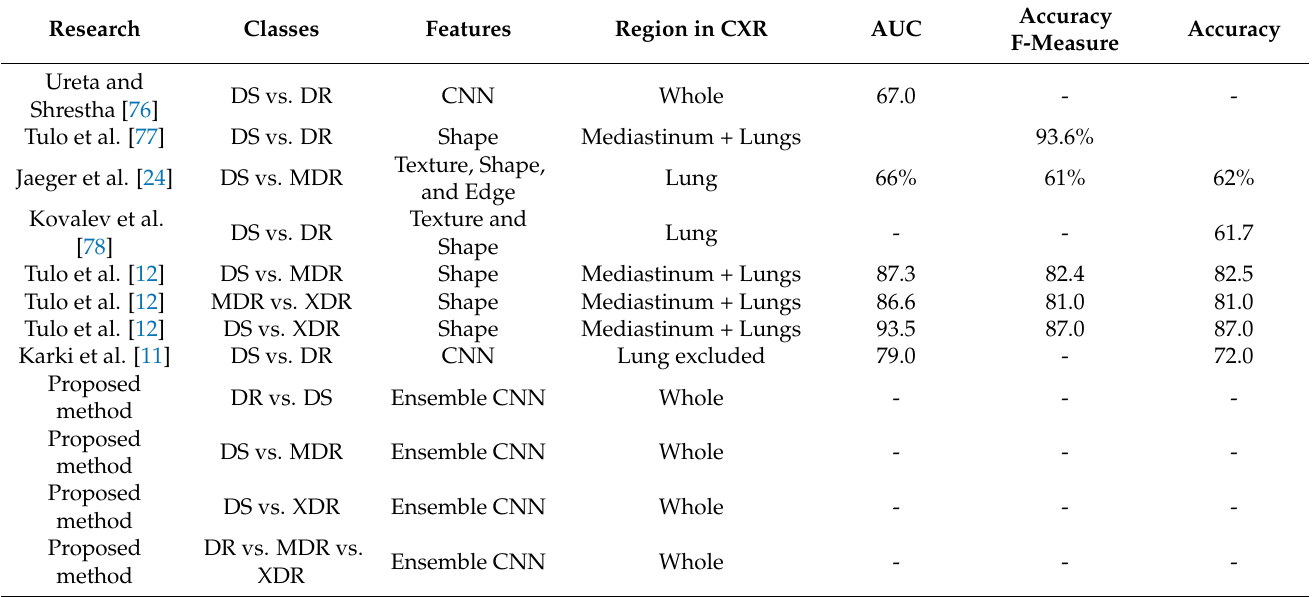
Table 2. Details of the compared method in the existing